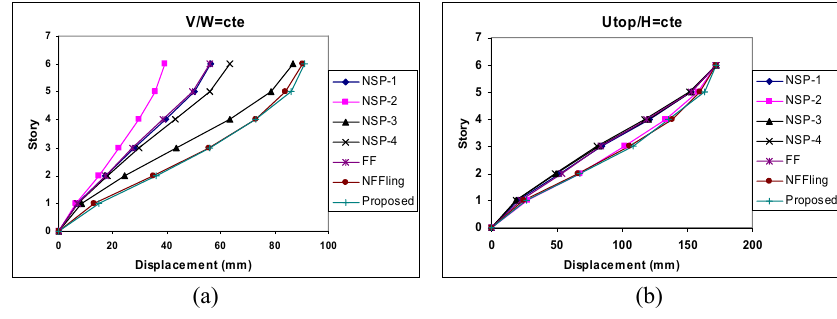
Figure 9. Peak displacement profiles for the 6-storey building with (a) V/W=cte, (b) U Fig. 9. Peak displacement profiles for the 6-storey building with (a) V/W = cte, (b) U top /H =